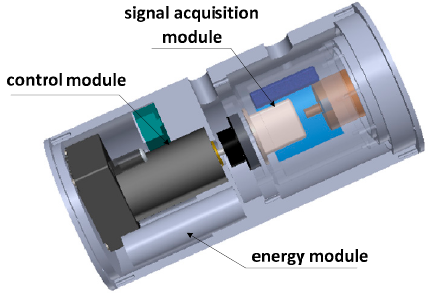
Figure 1. Arrangement of Semi-Strapdown INS.